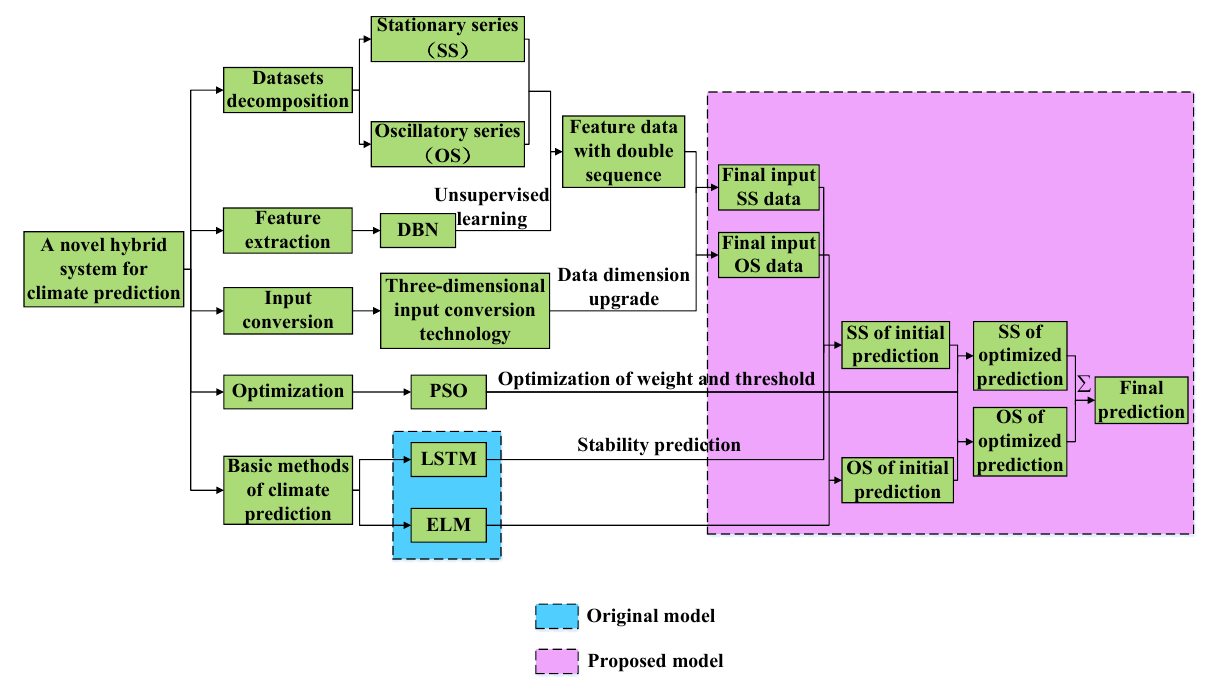
Figure 1. Overall flow chart of this paper.